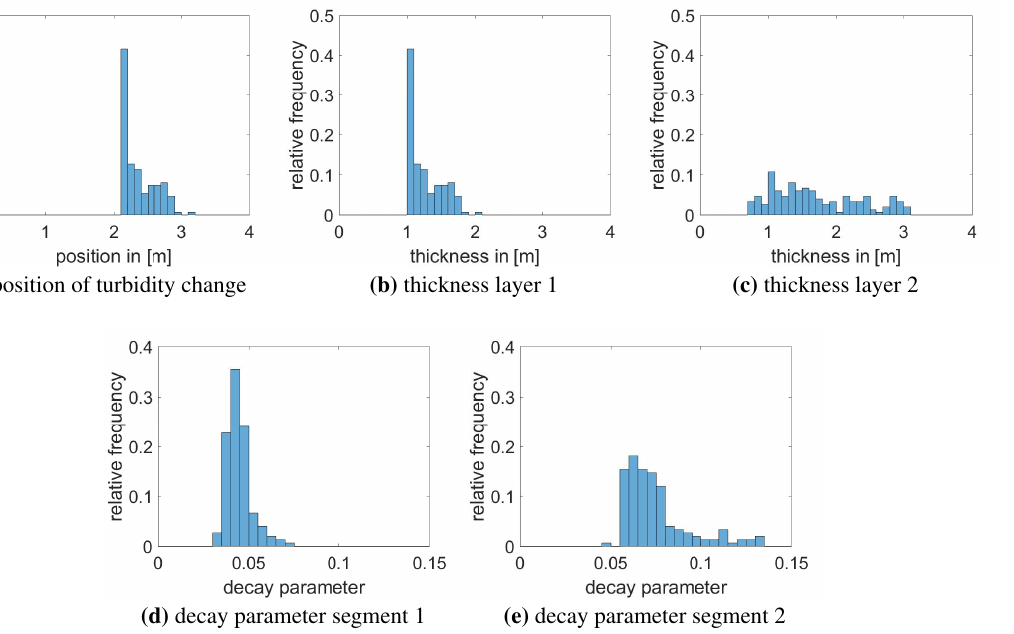
Figure 11. Position, thickness and decay parameter estimated from the real ortho full-waveforms in the study area. maximum at 2.2 m. Since the beginning of the water column is at a constant distance from the detected water surface echo, an identical characteristic. The maximum is located at 2.2